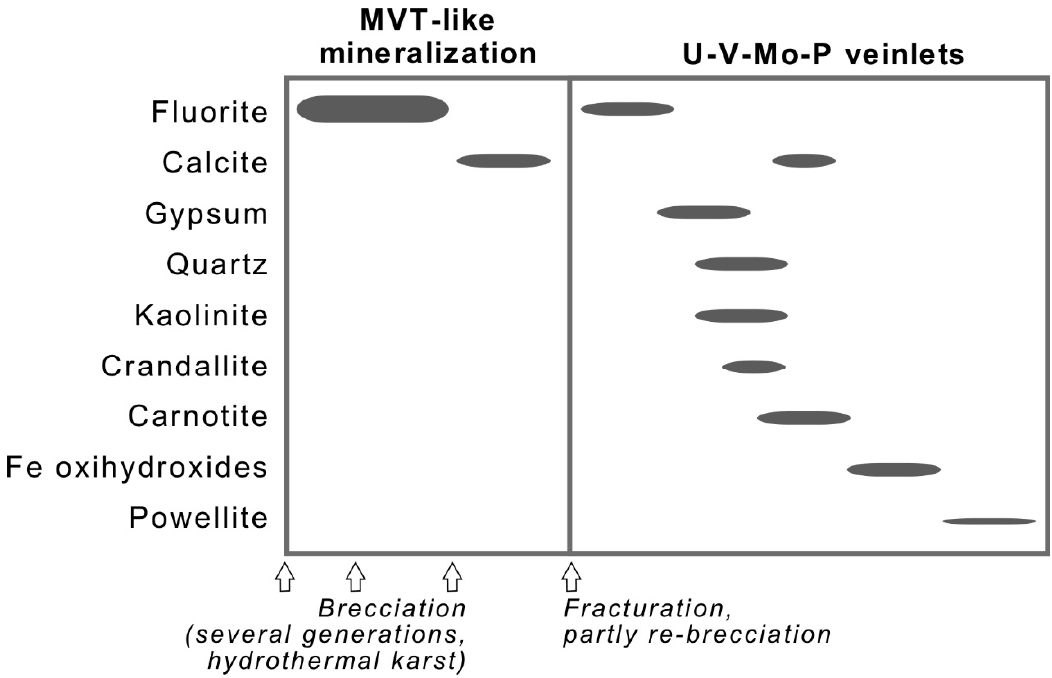
Figure 7. General paragenetic chart for the MVT-like fluorite and later fluorite–U–V–Mo–P mineralisation in the Aguachile–Cuatro Palmas area, Coahuila (based on the La Fácil and Las Alicias deposits).